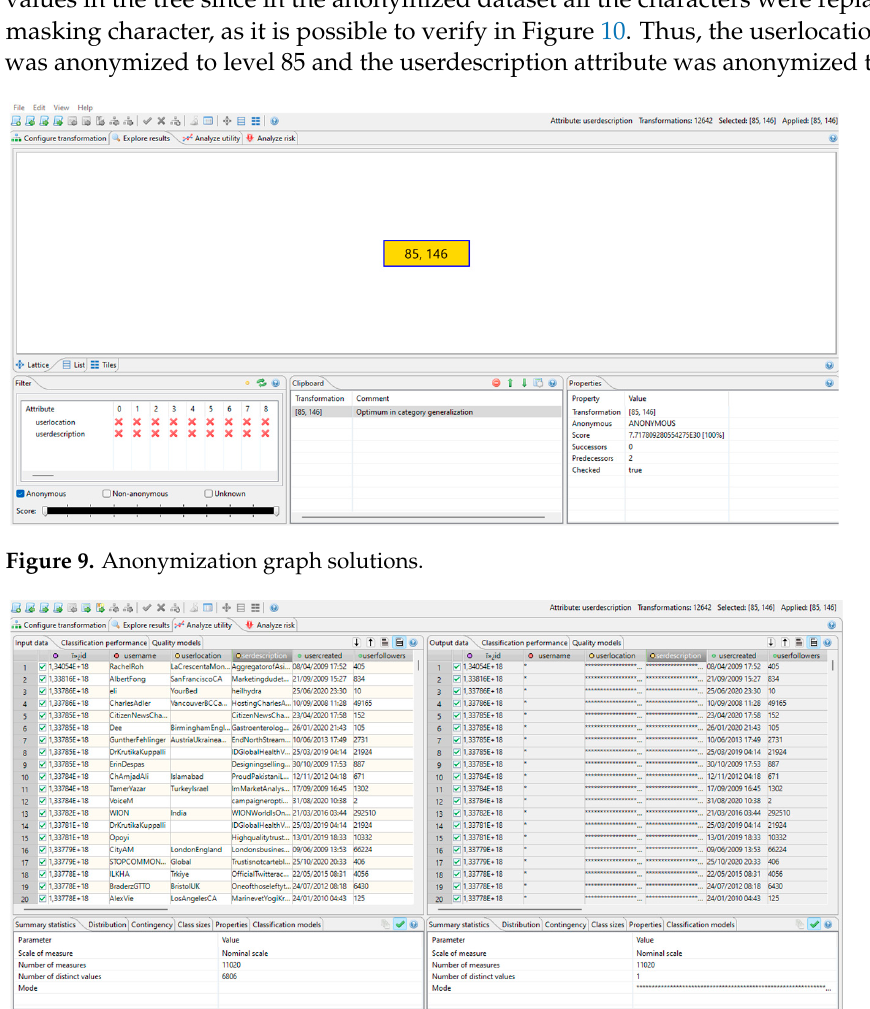
Figure 8. Hierarchy userdescription.